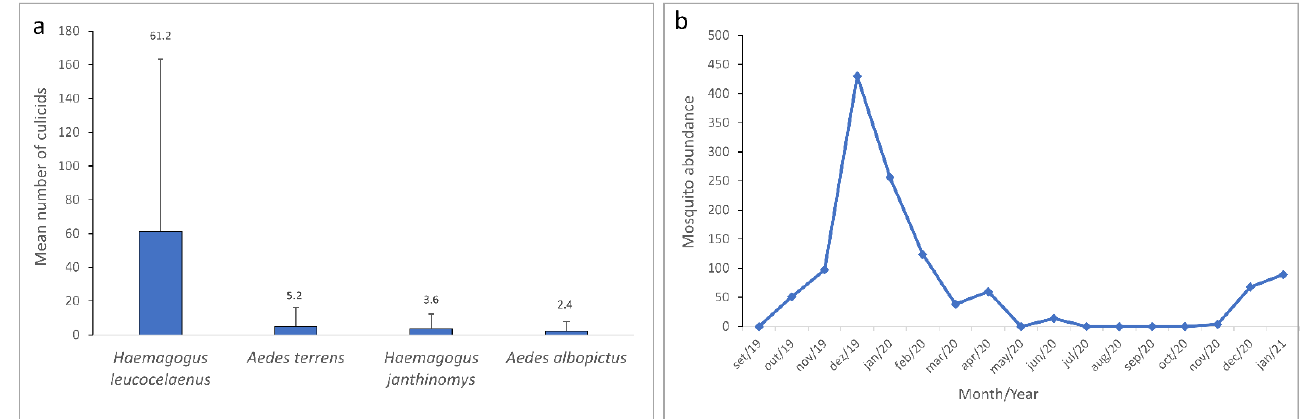
Figure 4. Culicidae of epidemiological concern collected from September 2019 to January 2021 in the Gaviões Reserve. ( a ) Mean and standard deviation for Haemagogus leucocelaenus , Aedes terrens , Haemagogus janthinomys , and Aedes albopictus . ( b ) Monthly mosquito abundance from September 2019 to January 2021.